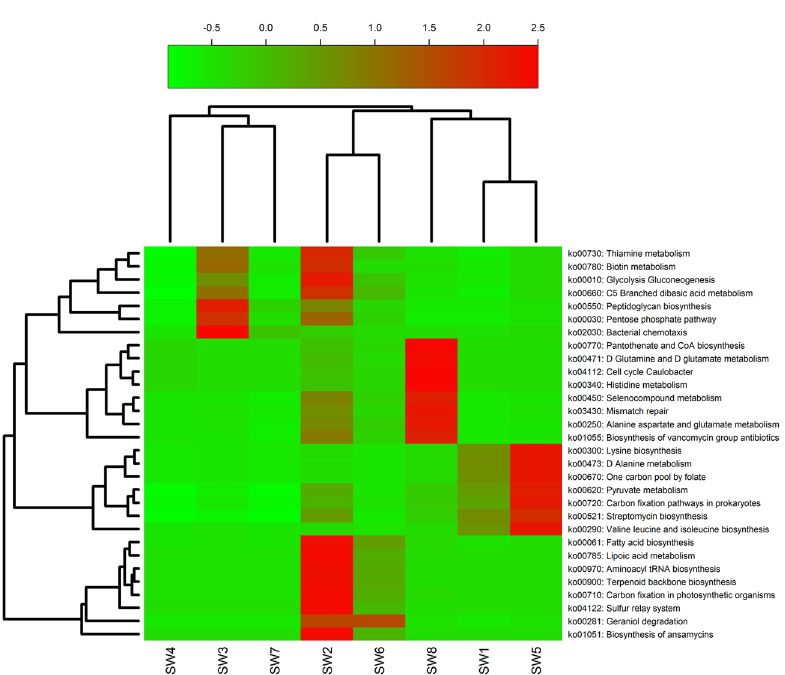
Figure 5. Functional prediction for epiphytic bacterial populations on collected seaweed